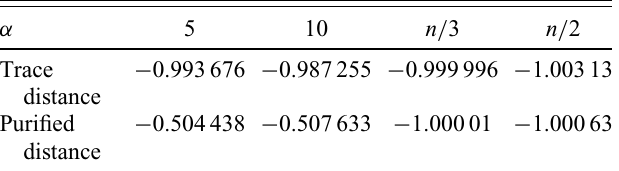
TABLE I. Numerical values of the slopes of the lines in Fig. 1 from linear